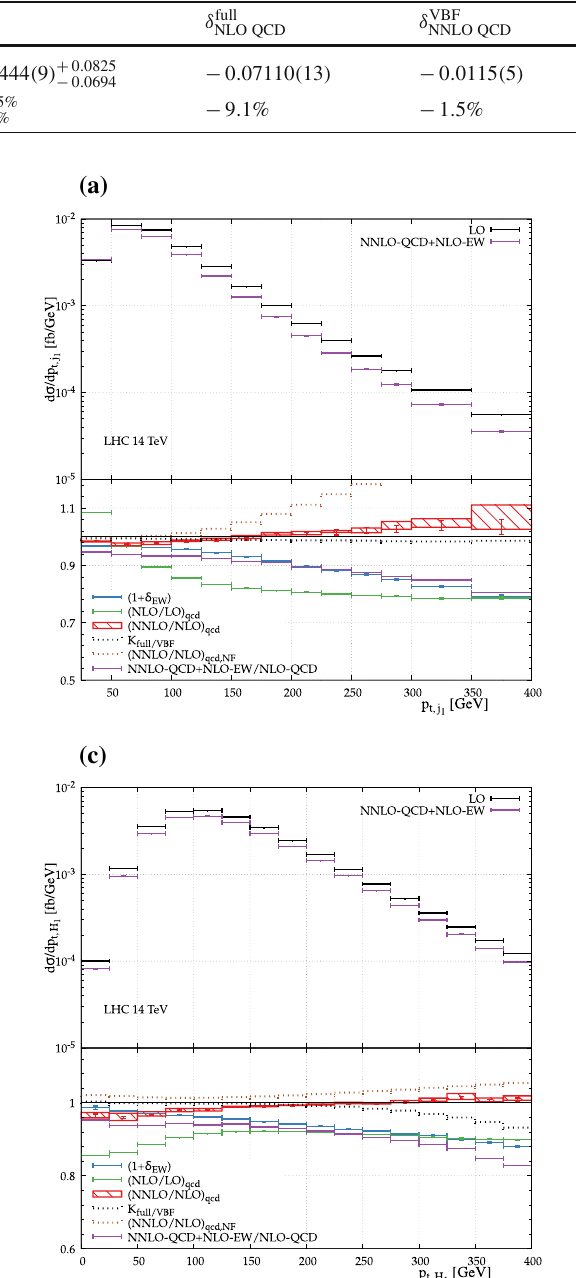
and σ NNLO QCD × NLO EW are the QCD scale variations. We also show δ NF separately. The value of the correction factor to go from the NNLO QCD VBFapproximationtothefullcomputationis K full / VBF = 0 . 99220 ( 11 ) LO